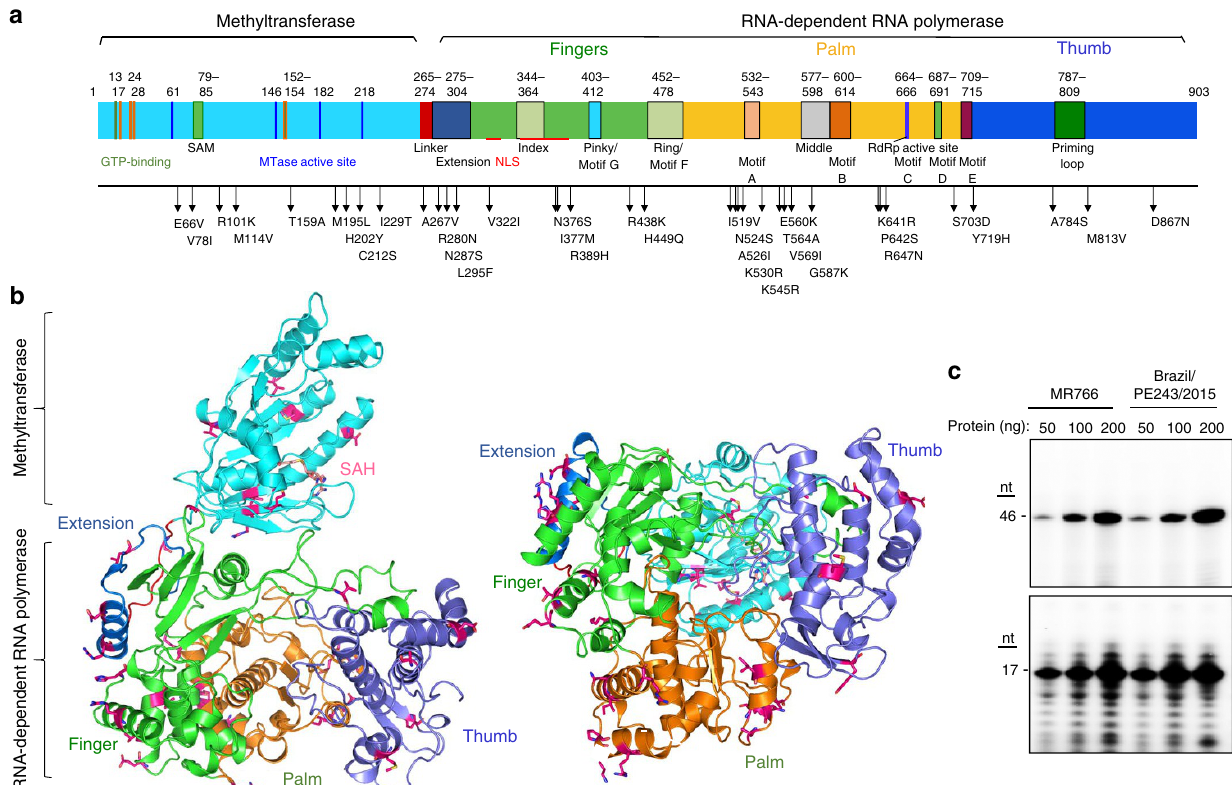
Figure 6 | NS5 protein from a ZIKV isolated from Brazil has comparable RNA synthesis as the MR766 NS5. ( a ) Schematic of the ZIKV NS5 showing the locations of the motifs and residues that are different in the NS5 from Brazil/PE243/2015 (GenBank KX197192.1) when compared to the MR766 (NC_012532.1). ( b ) Locations of residues in the Brazil/PE243/2015 in the context of the MR766 NS5 structure. The MT is coloured cyan. The fingers, thumb and palm subdomains in the NS5 RdRp are coloured green, slate and orange, respectively. Residues that differed in the NS5 from Brazil/PE243/2015 are shown in bright red sticks. ( c ) Comparison of RNA synthesis by the NS5 from isolate MR766 and Brazil/PE243/2015. The primer extension (PE) product is of 46-nt. The de novo -initiated (DN) production is of 17-nt. RNAs shorter than full-length are aborted during RNA synthesis or prematurely terminated. The RNAs longer than 17-nt in the DN assay are the result of terminal nucleotide addition to the template RNA. Uncropped gel images are shown in Supplementary Fig.